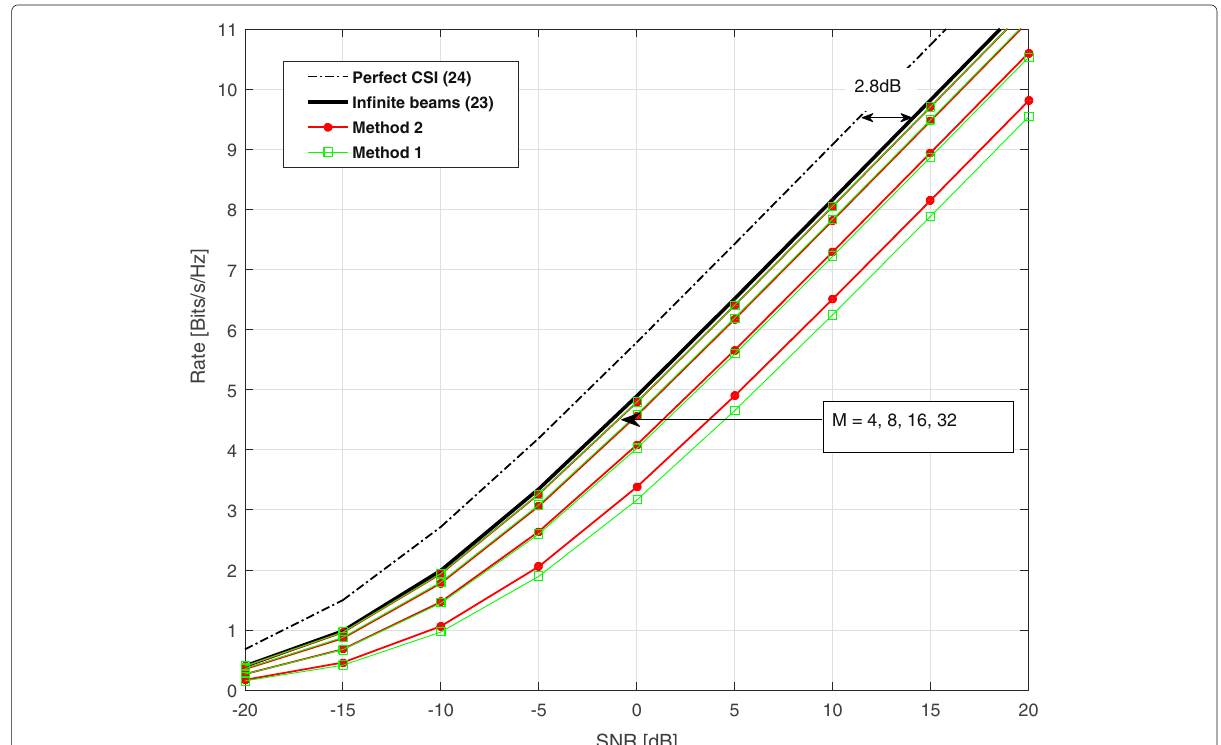
Fig. 3 Spectral efficiency achieved by Laplacian beam codebooks using the two sectorization methods for various numbers of codebook sizes M = { 4,8,16,32 } and N p =